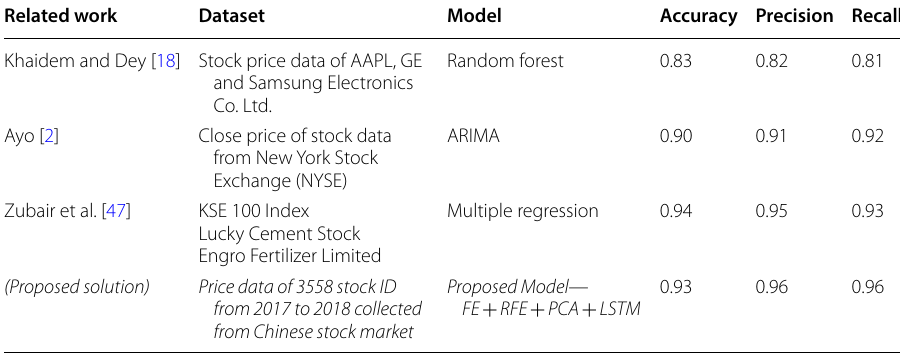
Table 8 Comparison of proposed solution with related works Related